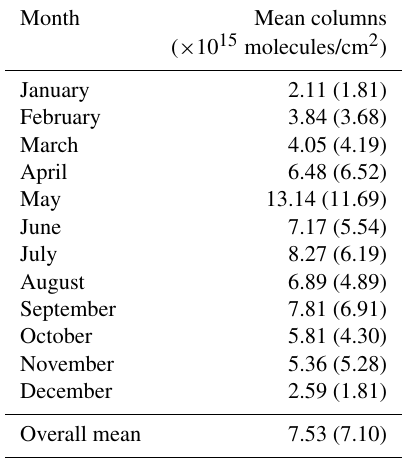
Table 1. Monthly mean (1 σ in parenthesis) NH 3 total columns of the TAO FTIR